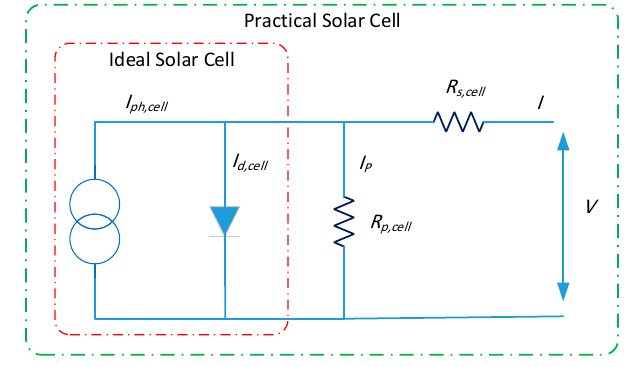
Figure 2. Photovoltaic equivalent circuit.